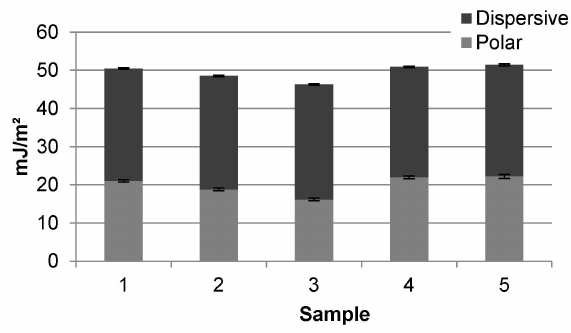
Figure 6. SFE components with error bars of APEX glass